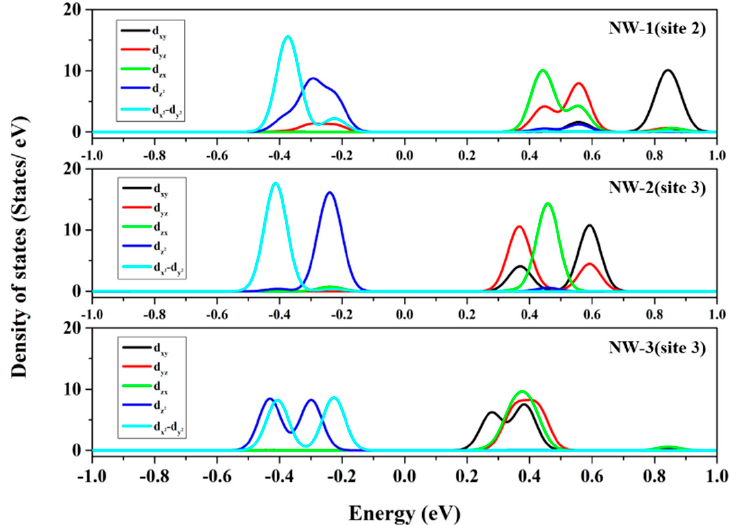
Figure 4. PDOS of Cr 2+ :ZnSe NWs of different sizes.